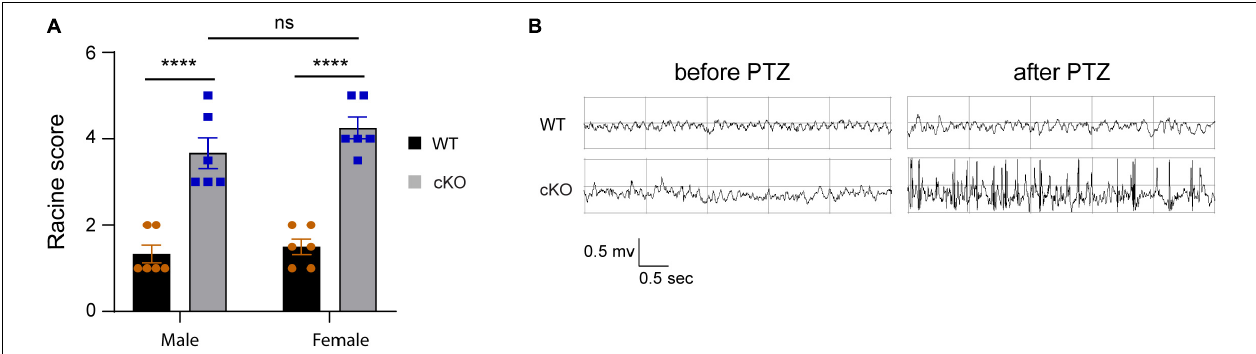
FIGURE 4 | Loss of Ash1l in the mouse brain reduces the thresholds for the PTZ-induced epilepsy. (A) Plots showing the Racine score of epileptic behaviors of male and female wild-type and Ash1l -Nes-cKO mice. n = 6 males and six females per genotype. P- value calculated using two-way ANOVA tests. Error bars in graphs represent mean ± SEM. **** p < 0.0001. (B) Representative electroencephalography (EEG) recording showing the electrical waves before and after sub-convulsant dose of pentylenetetrazole (PTZ) injection.